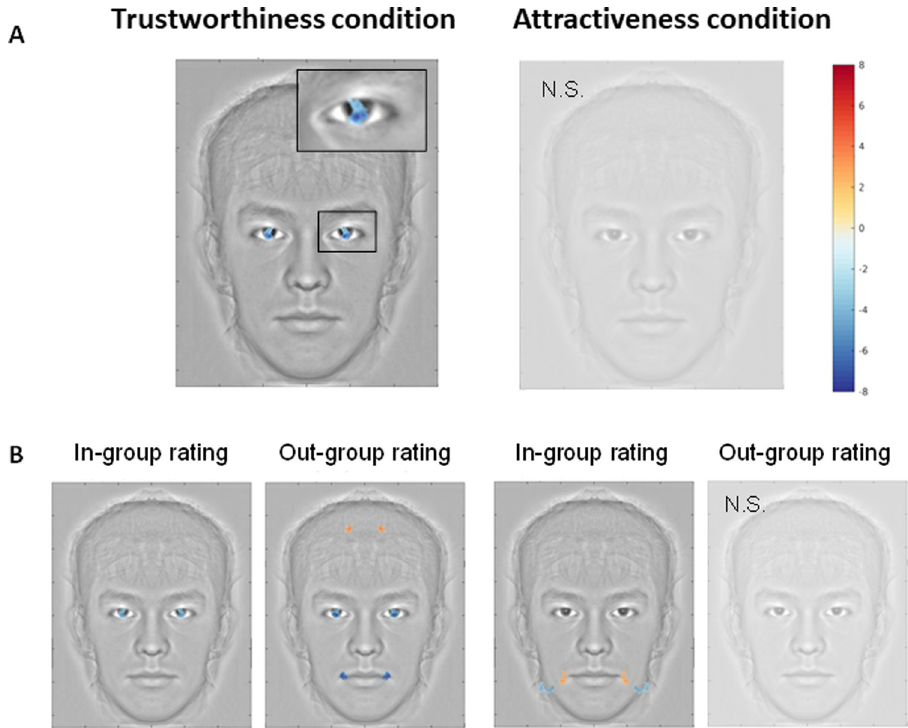
Fig 3. Conjunction analyses. Conjunction analyses reveal, among all participants’ classification images, which facial cues were consistently modulated by a trustworthiness or an attractiveness judgment. For each task, significantly modulated pixels were identified using a cluster-based permutation test (p < 0.05, FWER corrected for multiple comparisons). Then, only pixels that were significant for all considered tasks were conserved and the minimum observed z-score were displayed. A positive z-score indicates that the area is consistently lightened (i.e. subjects selected the picture in which this region contains more light pixels) while a negative z-score indicates that the area is consistently darkened (subjects selected the picture in which this region contains more dark pixels). (A) Conjunction analysis between both populations (Chinese, French) and two stimuli types (Asian, European descent) for the trustworthiness (left) and attractiveness (right) judgments. Results showed a clear and significant pattern of classification across populations and faces only for trustworthiness judgments. For this condition, Chinese and French participants darkened selectively the face area within the pupil-iris area of the eyes to make the face more trustworthy (see zoom). No equivalent selective area overlapped for attractiveness judgements. ( B) Partial conjunction analyses for in-group (Chines rating Asian faces + French rating European descent faces) and out-group (Chinese rating European descent faces + French rating Asian faces) ratings for a trustworthiness (left) and an attractiveness (right) judgment. For trustworthiness in-group ratings, participants darkened the eyes area; while for out-group rating participants not only darkened this area, but also the extremity of the mouth, as though to make the faces more smiley. This result suggests that the smile is not the most reliable cue for a trustworthiness judgment in our everyday social environment. However, the smile remains an important cue for rapid and automatic evaluation of strangers. Concerning attractiveness, for in-group ratings, participants darkened the upper part of the jaw and lightened the extremity of the mouth, thus forming a chiseled jawline for the attractive face and a more rounded appearance for the non-attractive picture. However, for out-group ratings, no face region emerged as